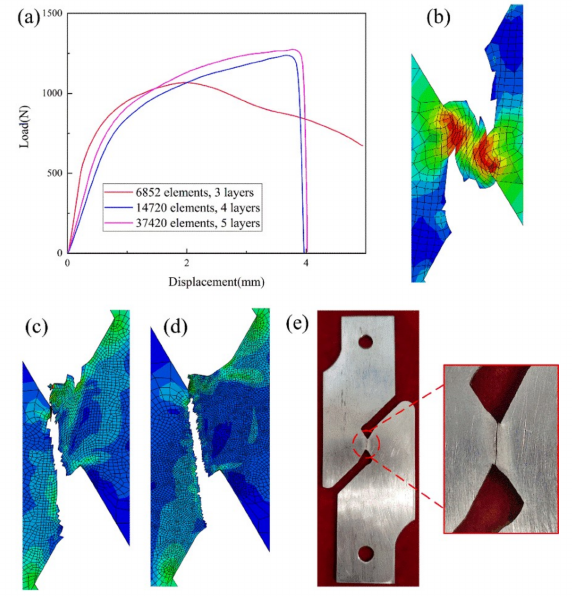
Figure 7. The Load-Displacement curves and crack shapes with different number of meshes: ( a ) Load-Displacement curves; ( b ) Crack shape with 6852 elements, 3 layers; ( c ) Crack shape with 14,720 elements, 4 layers; ( d ) Crack shape with 37,420 elements, 5 layers; ( e ) The result of